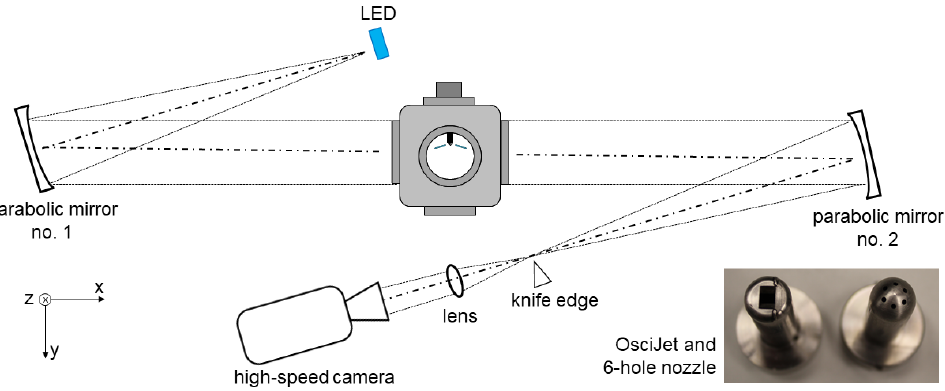
Figure 2. Schematic drawing of the schlieren system and nozzles